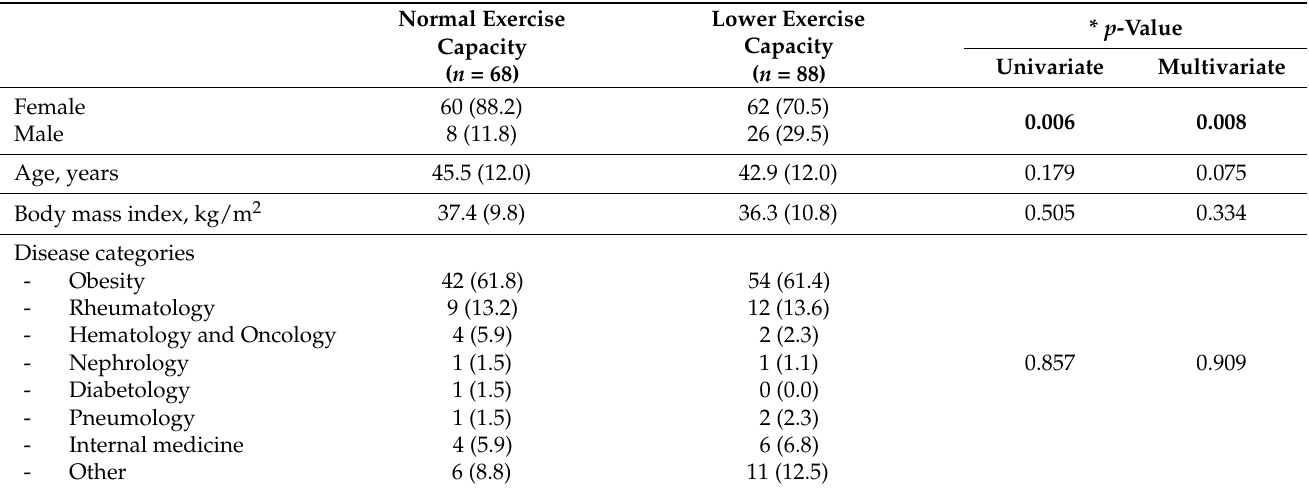
Table 1. Baseline demographic and clinical characteristics ( n =